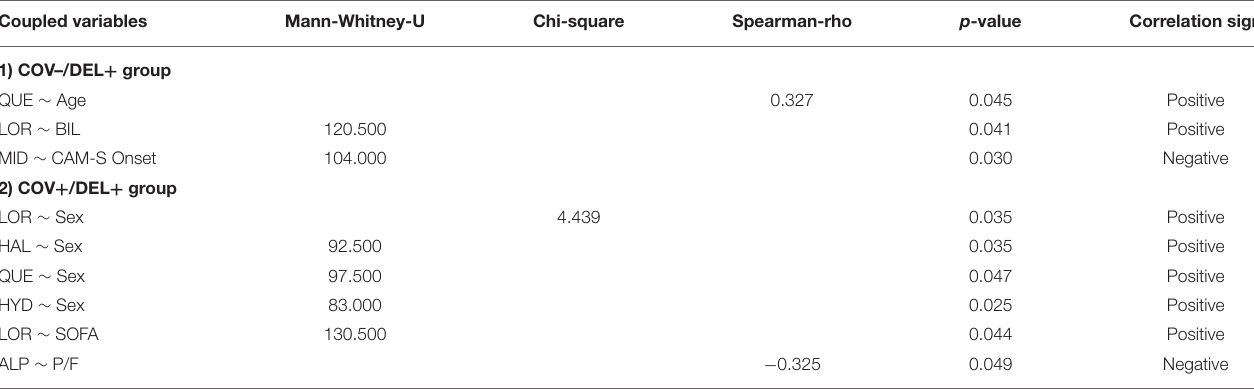
For each couple of variables, the direction of the correlation (positive/negative) is indicated. For correlations with the “Sex” variable, a positive and negative direction referred to an increased frequency of males or females.